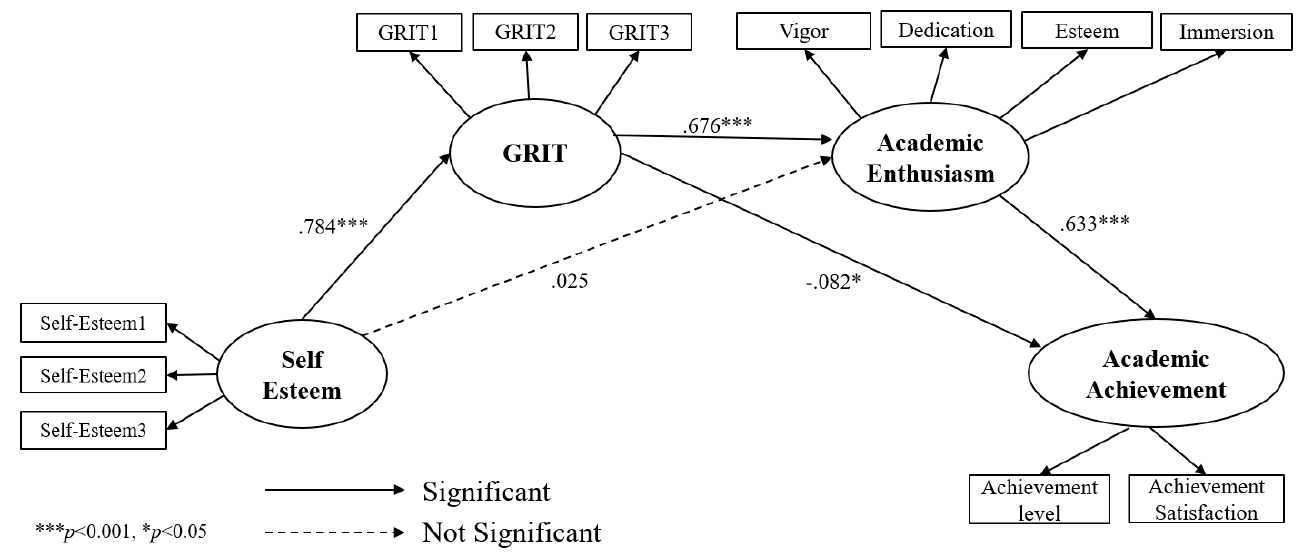
Figure 3. Partial mediation model.